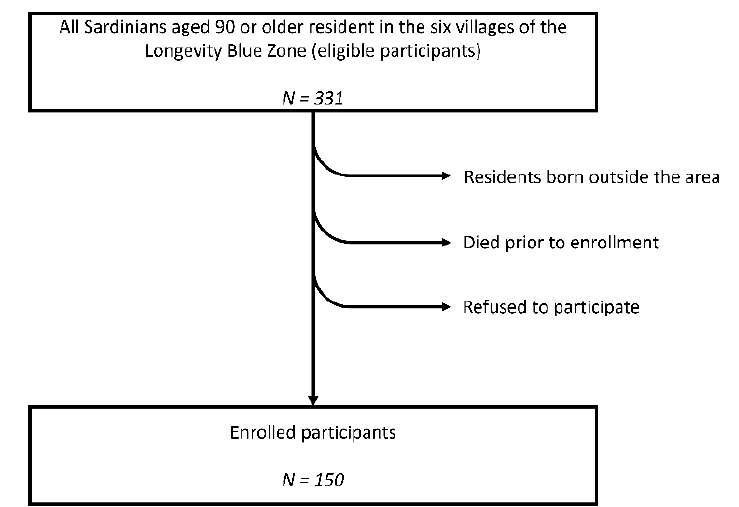
Figure 1. Recruitment process flowchart.